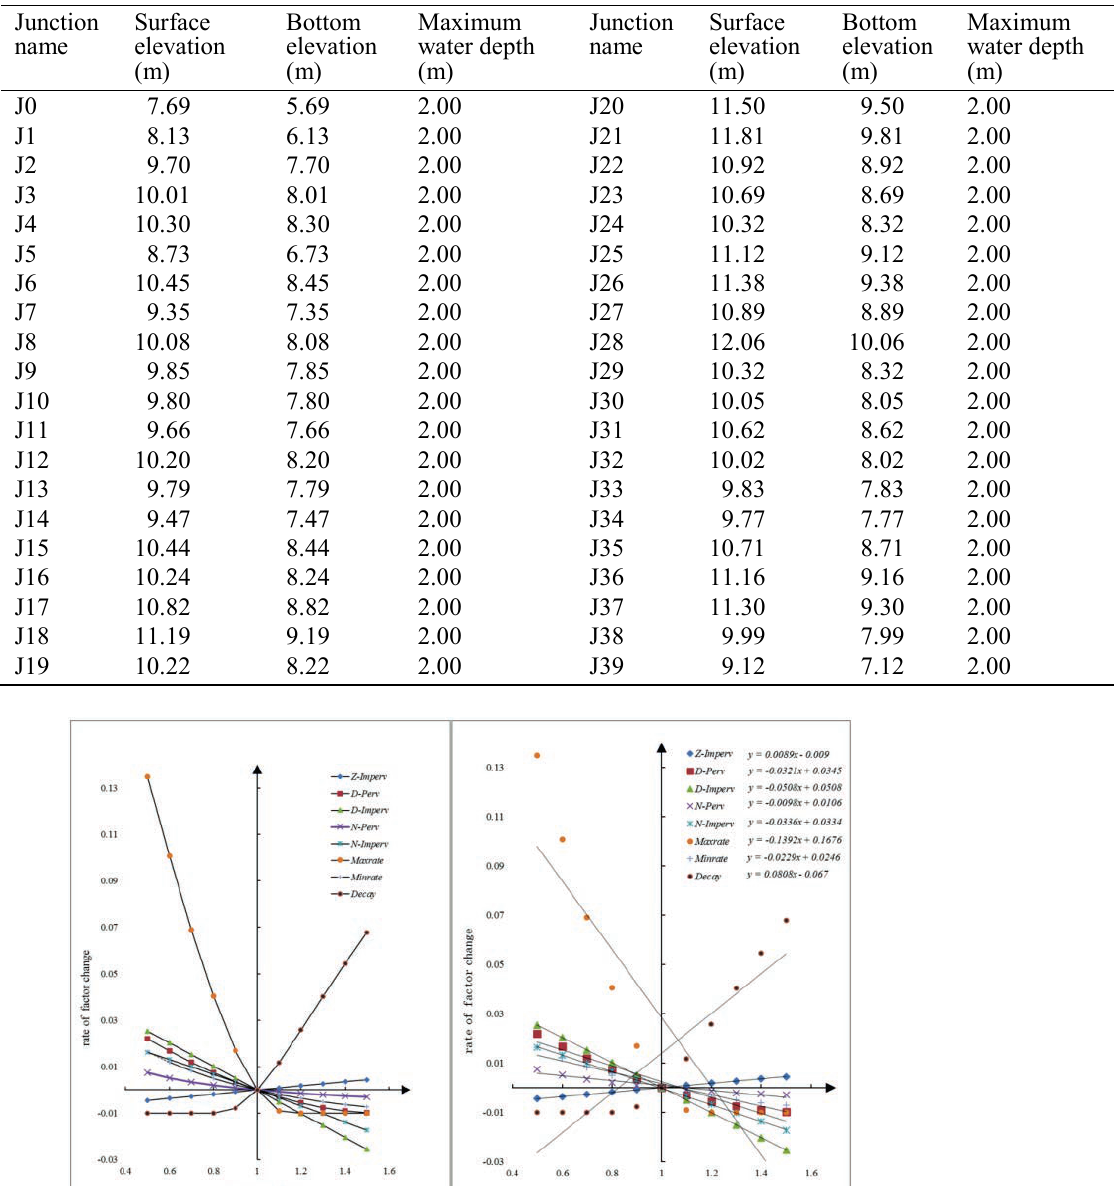
Table 2 Properties of the junctions.